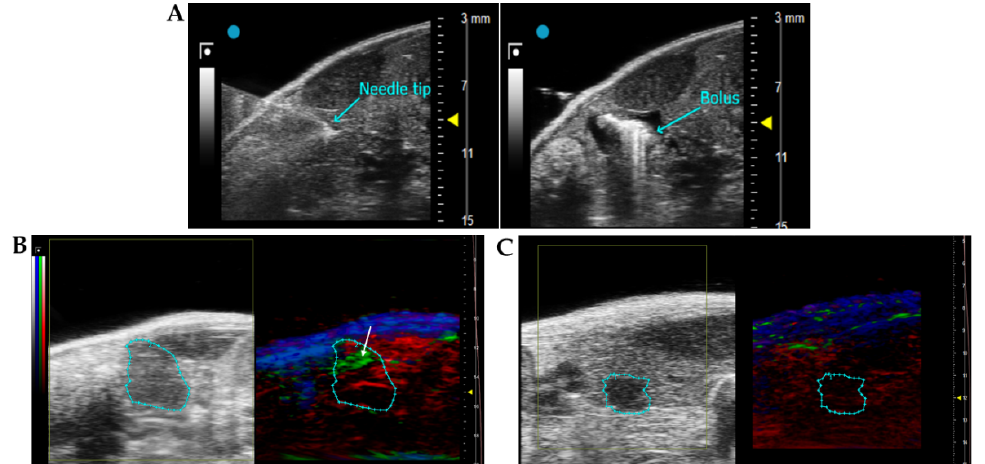
Figure 5. Injection procedure for obtaining the PDAC mouse model and imaging of the tumour masses in the pancreas. ( A ) Ultrasound acquisition during the US-guided injection on PANC-1 cells into the pancreas. In the left panel, the needle tip at the moment of injection is into the pancreatic tail. The correct injection of the bolus is checked by the presence of a bubble in the pancreas (right panel). ( B , C ) 2D US (left panels) and PA (right panels) images of tumour masses acquired 1 h after the intravenous injection of 16 mg/kg of scDb-hERG1- β 1 conjugated with ICG ( B ) and 1 mg/kg ICG ( C ). The tumour is bordered by the cyan region of interest (ROI). In the right panels, obtained by PA imaging, red areas indicate the presence of oxyhaemoglobin, blue areas indicate the presence of deoxyhaemoglobin, and the green spots indicate the ICG signal (pointed out by the white